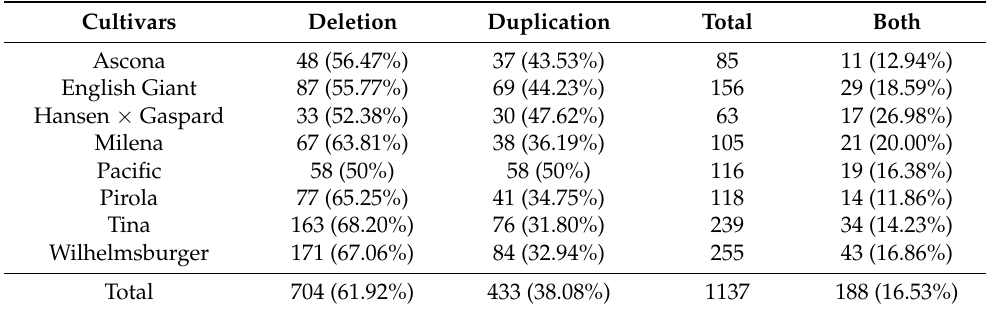
Table 1. The number and percentage of CNV events in RGAs (i.e., deletion, duplication and both deletion and duplication) in eight B. napus